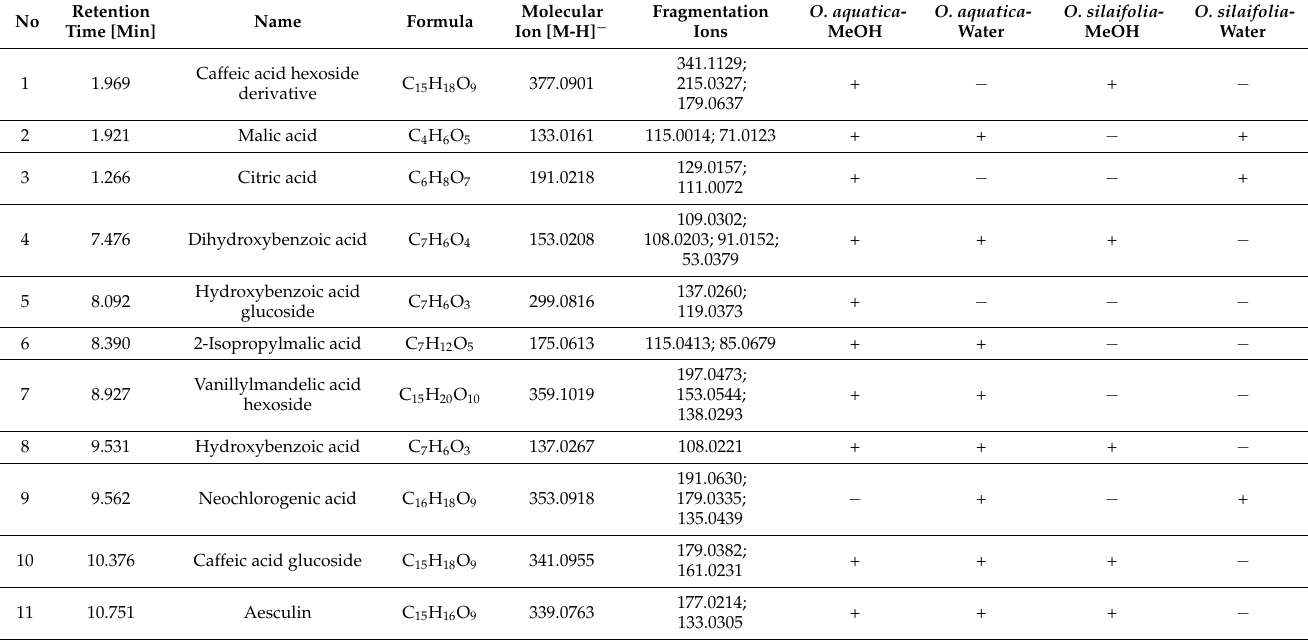
Table 2. The chemical composition of studied